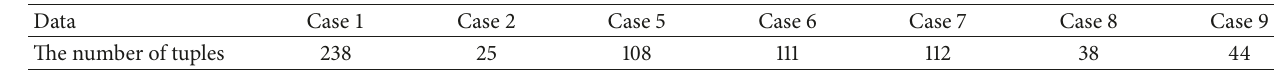
Table 4: Number of tuples on the training